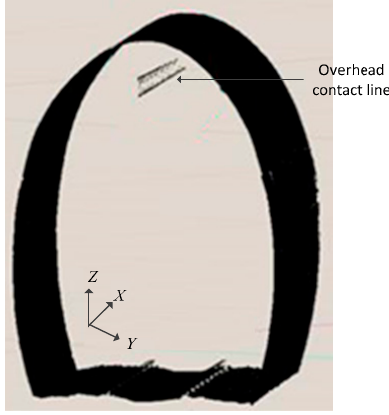
Figure 13. Point cloud of tunnel and OCL .